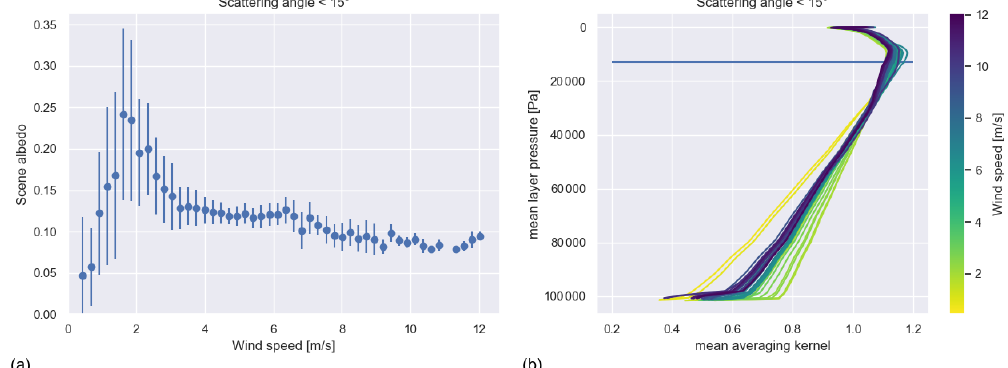
Figure 4. (a) Change in effective scene albedo with wind speed over the Central Mediterranean north of Libya in June–July–August 2018 (see gray rectangle in Fig. 1 c ) for scenes with scattering angles smaller than 15 ◦ ( ≈ 22000 data points in total). The error bars indicate the standard deviation of each bin. (b) Mean averaging kernel (profiles) for different wind speeds, sampled as for (a) . Only pixels with cloud radiance fractions < 0 . 25 or p surf − p cloud ≤ 300Pa were selected. The horizontal blue line in (b) indicates the average tropopause